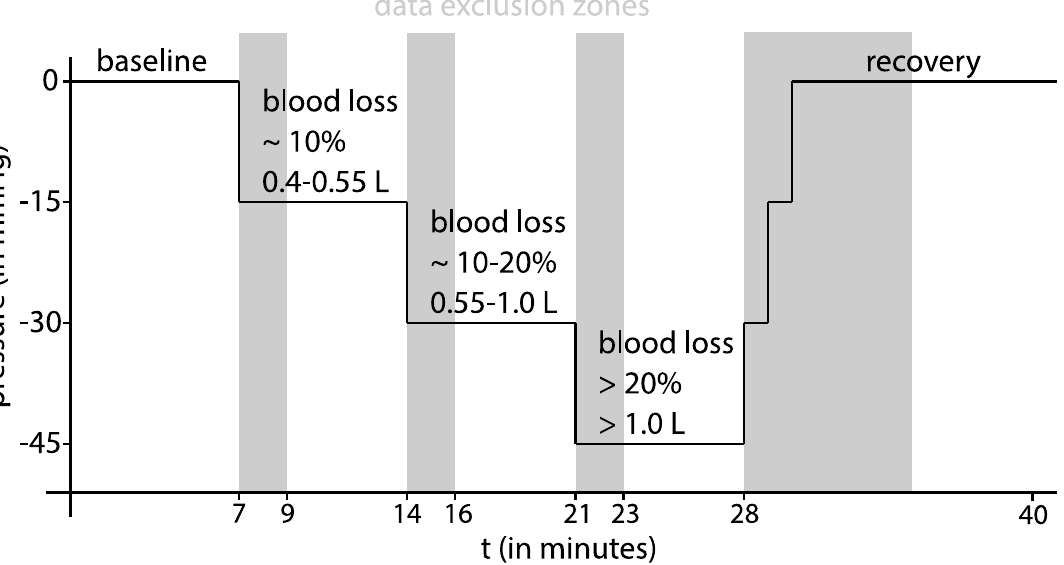
Figure 1. Time course of the LBNP study protocol: the expected simulated blood loss is given in accordance to [19]. The first two minutes of each LBNP stage and the first seven minutes of the recovery stage were excluded from any further analysis. These data exclusion intervals are marked in grey.